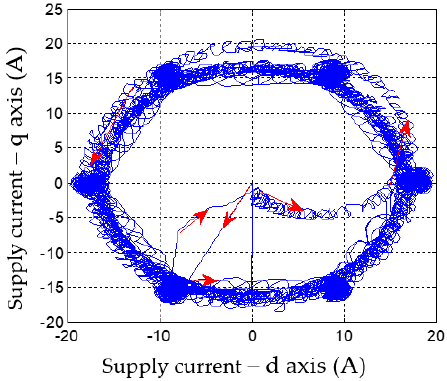
Figure 10. The evolution of the supply current phasor.